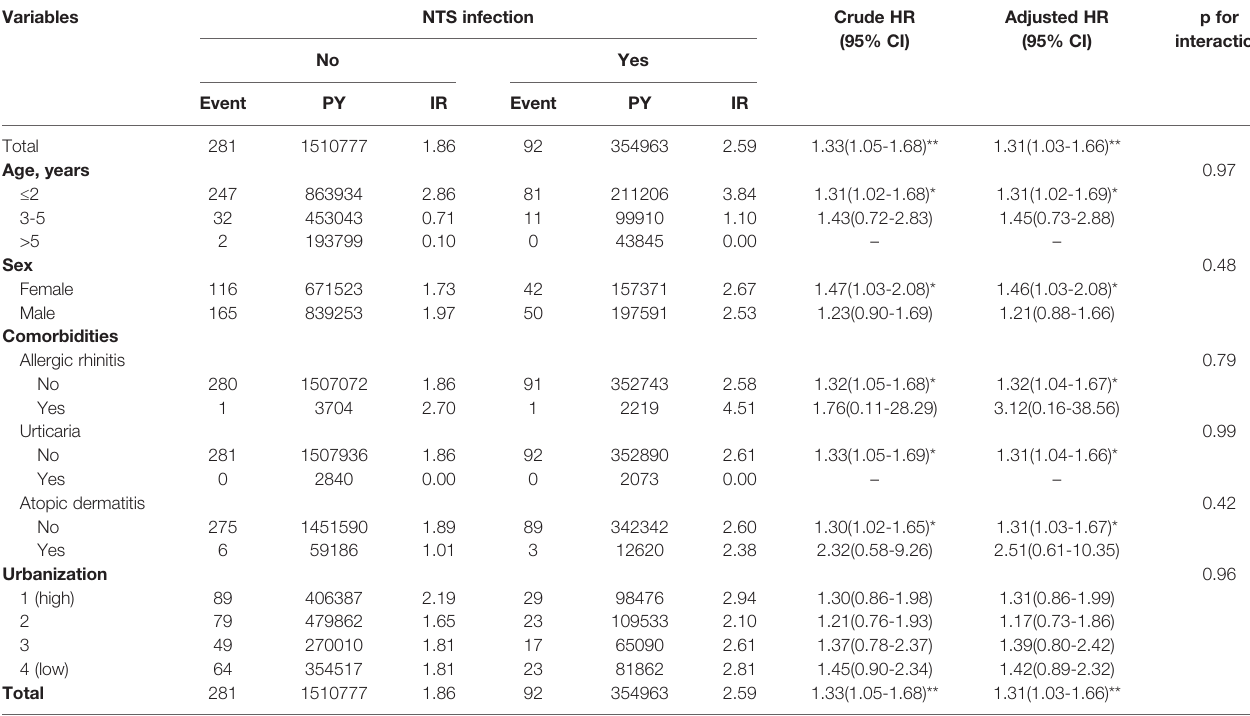
TABLE 3 | Subgroup analysis.